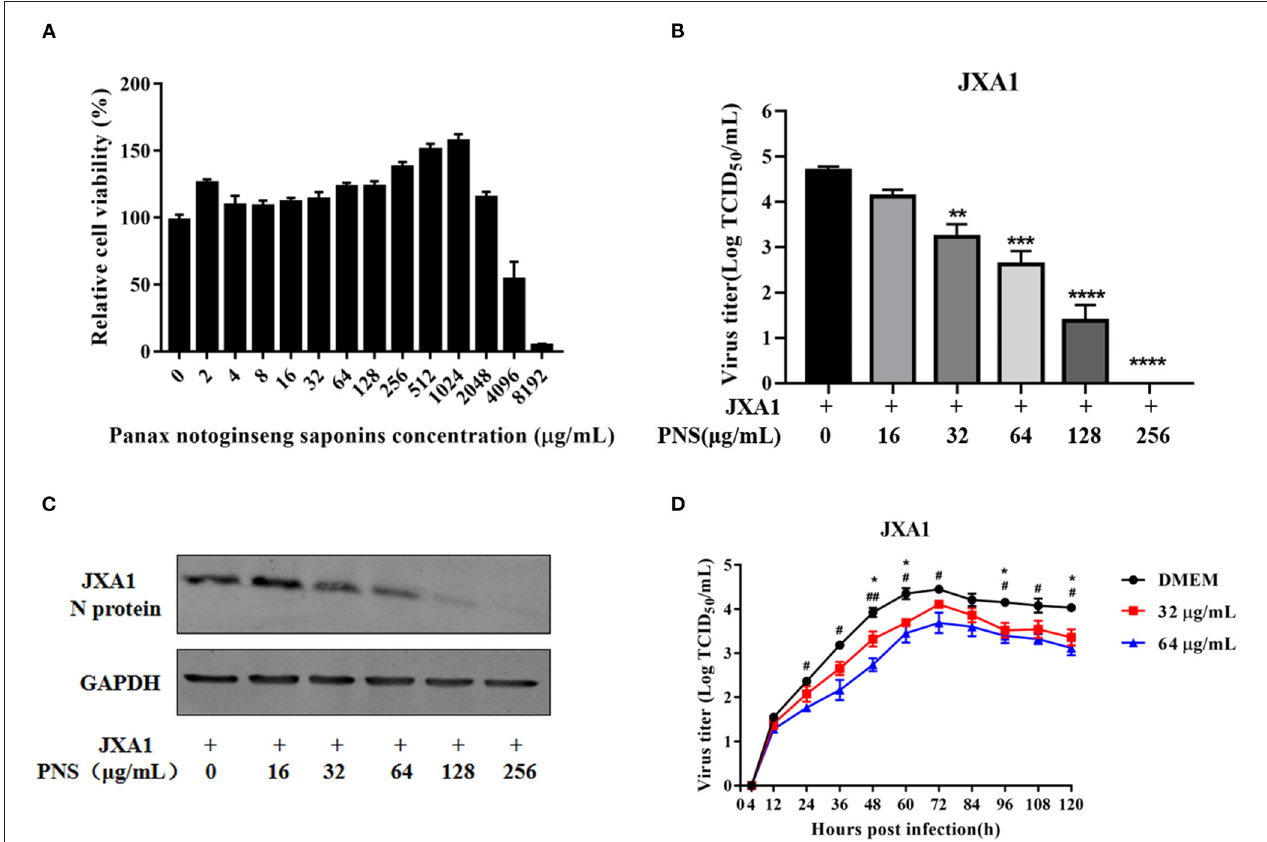
FIGURE 1 | Cytotoxicity and anti-PRRSV activity of PNS in Marc-145 cells. (A) Determination of PNS cytotoxicity in Marc-145 cells. Cells were incubated with 0, 2, 4, 8, 16, 32, 64, 128, 256, 512, 1,024, 2,048, 4,096, and 8,192 µ g/mL PNS for 48h before CCK8 assay. (B,C) Marc-145 cells were treated with PNS at 0, 16, 32, 64, 128, and 256 µ g/mL for 48h after JXA1 infection (MOI of 0.05 TCID 50 per cell) for 1h. The infected cells were cultured in the presence of PNS at different concentrations. The cells and supernatant were harvested at 48 hpi for the TCID 50 assay and western blotting analysis. Western blotting analysis was performed using PRRSV N-protein antibody, and GAPDH served as loading control. (D) Marc-145 cells were incubated with JXA1 strains (MOI of 0.05 TCID 50 per cell) for 1h at 37 ◦ C in DMEM supplemented with 0, 16, 32, 64, 128, and 256 µ g/mL PNS. Supernatants were collected 4, 12, 24, 36, 48, 60, 72, 84, 96, 108, 120h after inoculation for virus titer determination. Statistical significance is denoted by * p < 0.05, ** p < 0.01, *** p < 0.001. # p < 0.05, ## p < 0.01, ****p < 0.0001.